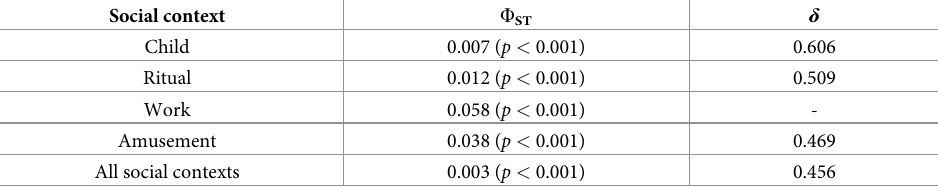
Table 3. F ST and δ values among ten islands in the Ryukyu Archipelago (Amami-Oshima, Okinawa, Miyako, Ikema, Irabu, Tarama, Ishigaki, Taketomi, Hateruma, and Yonaguni islands) for songs associated with each social